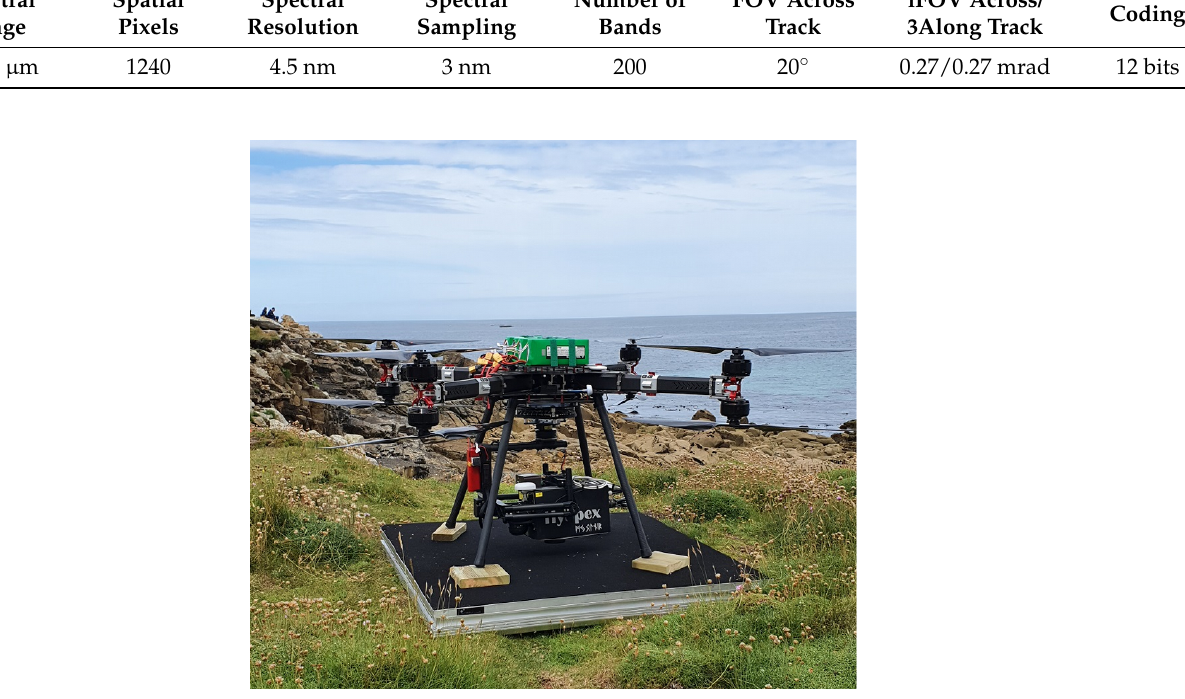
Table 1. Characteristics of the hyperspectral visible near infrared (VNIR) Mjolnir_V-1240 sensor. FOV = field of view.